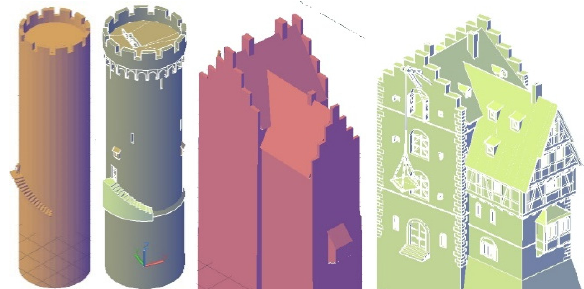
Figure 5. Comparison between initial and final model for the keep (left) and a building at the main castle